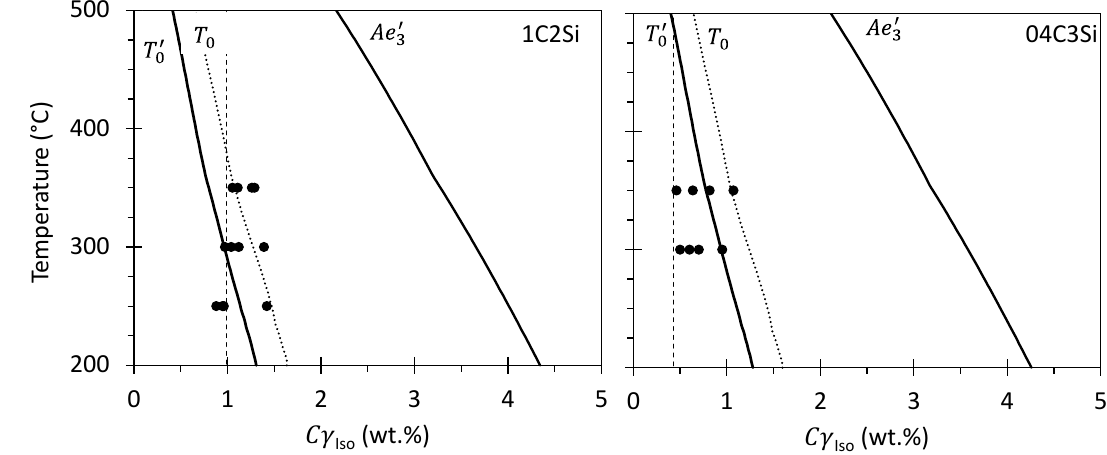
Figure 9. A comparison of determined carbon content of austenite at different isothermal T ( C γ Iso ) values, solid circles, against calculated T , T (cid:48) and Ae (cid:48) phase boundaries. Vertical dashed line represents the average C content of the alloy.